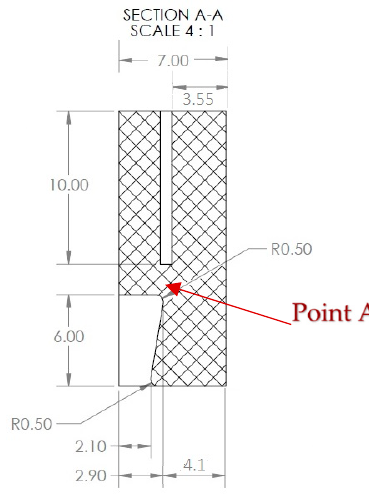
Figure 27. Plastic component 2D cross ‐ section.